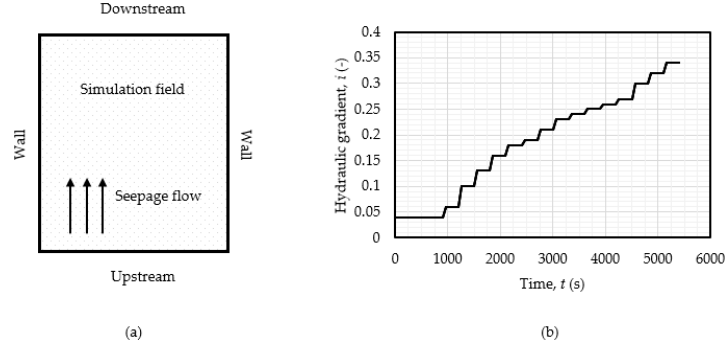
Figure 7. ( a ) Simulation domain and ( b ) loading history of hydraulic gradient of Run B by Skempton and Brogan [9].